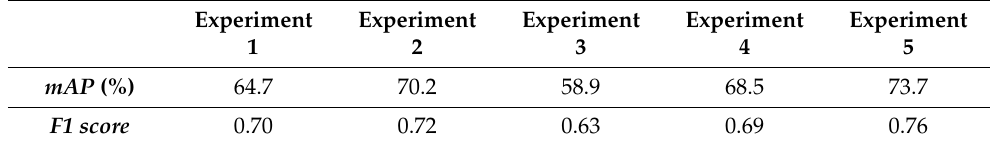
Table 15. Results of YOLOv5s on CCTSDB2021 dataset.